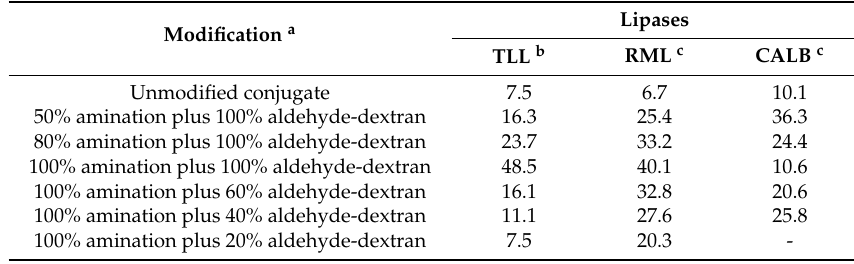
Figure 6. Unmodified and fully aminated surfaces of TLL. ( a ) Lid (red); Glu and Asp residues (yellow); and Lys residues (blue); ( b ) Lid (red); and Glu, Asp, and Lys residues (blue). The image was obtained using the PyMOL 1.74 program from the structure of the intact Thermomyces lanuginosus lipase (PDB code 1TIB). Table 2. Conserved activities (%) of the different immobilized lipase preparations after 24 h of thermal inactivation process.